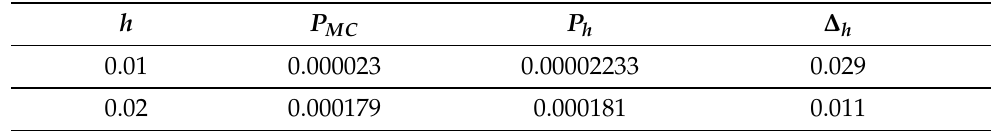
Table 1. Results of P MC , P h , ∆ h